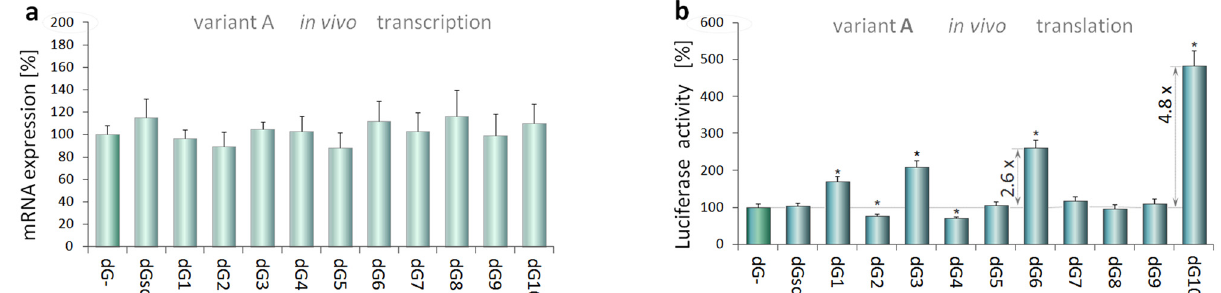
Fig 6. dGoligo-mediated gene expression changes in Caki-2 cells. Effects of 2 ’ -O-methyl RNA oligonucleotides on luciferase transcription (panel a ) and translation ( b ) in Caki-2 cells transfected with pGL3-A. MicroRNA-like dG10 and microRNA-like dG6 exerted the strongest translation-enhancing effects in Caki-2 cells (4.83-fold and 2.60-fold respectively). Results from three independent experiments performed in triplicates are shown as mean % mRNA (a) or luciferase activity(b) ± SD. Data analyzed by ANOVA followed by Dunnett ’ s multiple comparison test. * p < 0.001 vs.